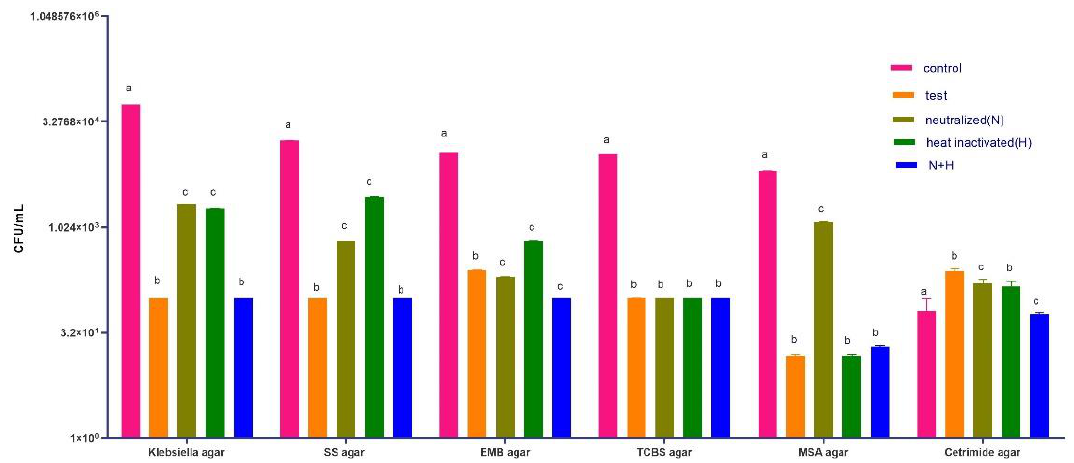
Figure 7. Effect of ACF on the reduction of presumptive pathogens in wastewater. The wastewater sample treated with ACF served as test and the untreated wastewater served as control. The ACF neutralized (N), heat-inactivated ACF(H) and ACF neutralized and heat-inactivated (N+H) were also used in the study. The reduction of presumptive pathogens was determined by CFU enumeration in selective and differential media (Klebsiella agar, SS agar- Salmonella Shigella agar, EMB agar- Eosin Methylene blue agar, TCBS –Thiosulfate citrate Bile Salts sucrose agar, MSA-Mannitol Salt agar and Cetrimide agar) after 24 h of incubation. Values are means ± standard deviation of three replicates. Different letters a, b and c indicate significant differences of treatment at p < 0.001 level (Bonferroni test) in their respective media.